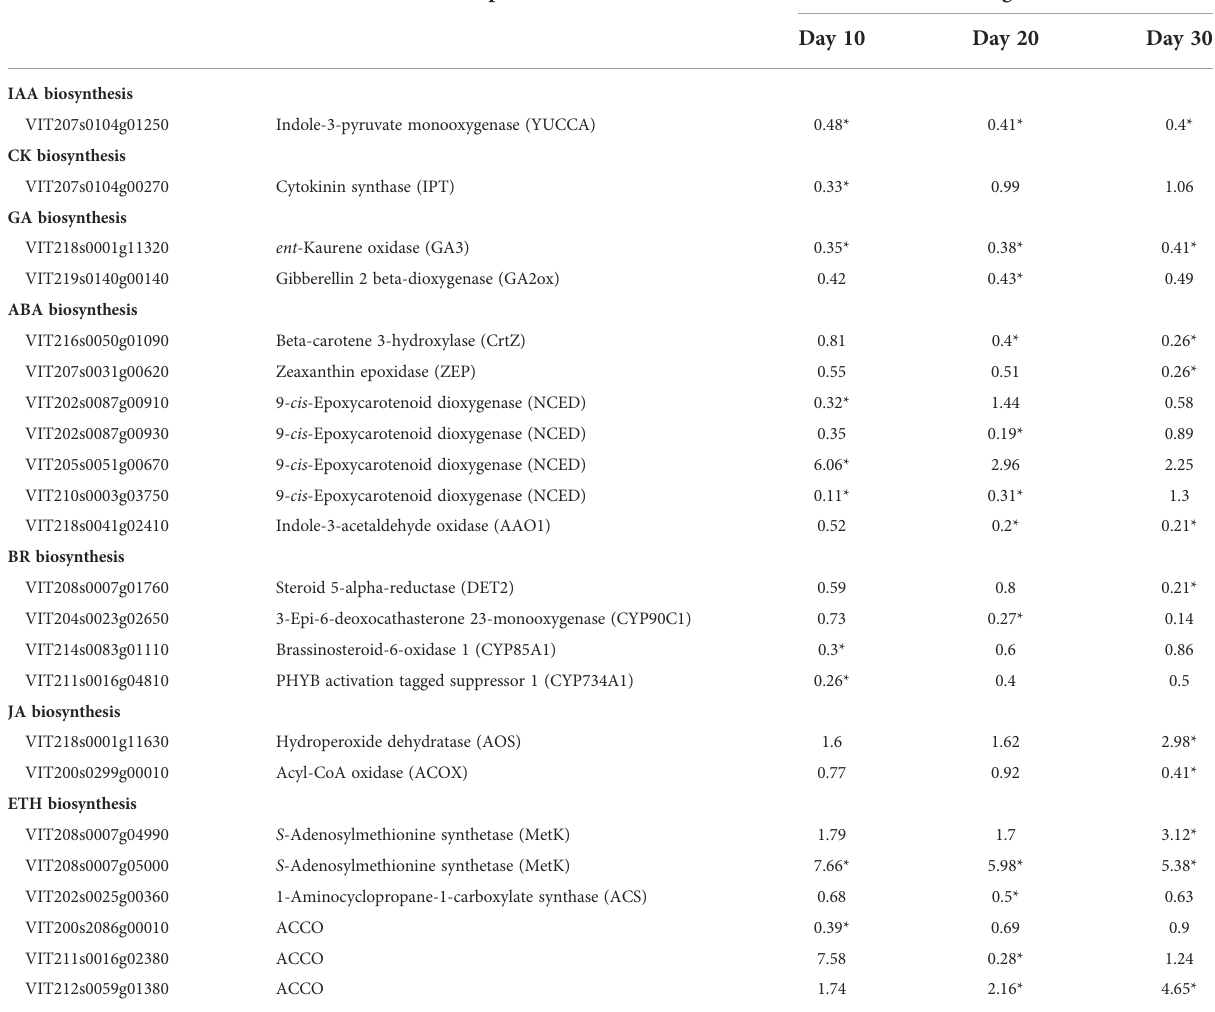
TABLE 1 Changes in the expression of DEGs related to plant hormone biosynthesis. Gene ID